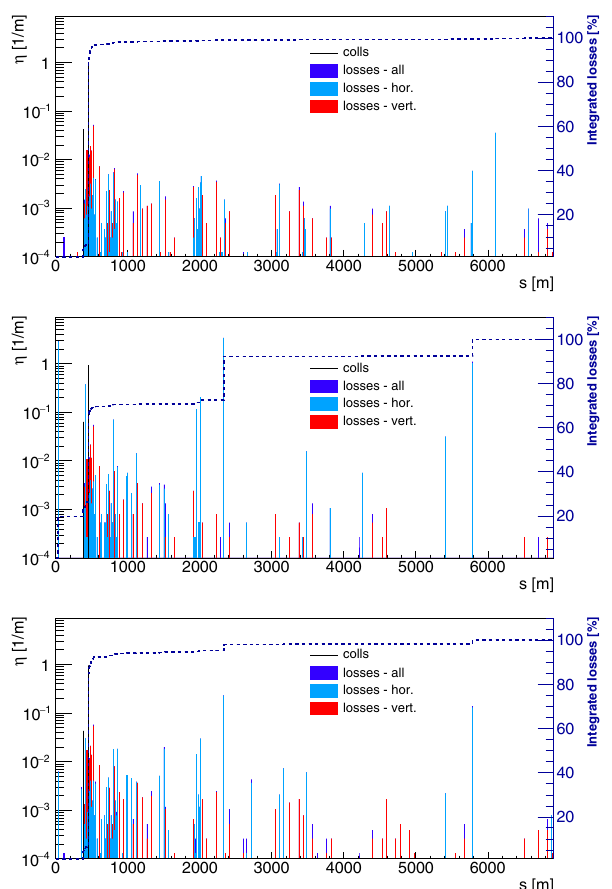
FIG. 8. Global cleaning efficiency after fixing a flange next to a given defocusing quadrupole. For each data point all the flanges to the left of it are also fixed. Data points are joined to guide the